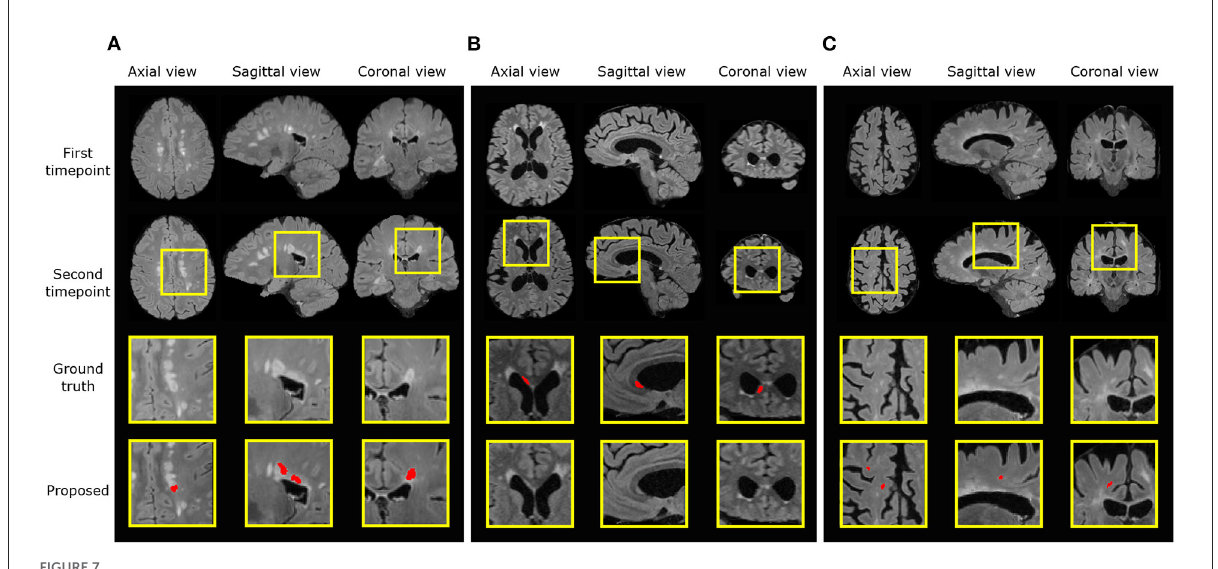
FIGURE7 Examples of three different sources of error. Ground truth and predicted lesions are delineated in red. (A) (subject ID: 012) False positive segmentation of a growing lesion. (B) (subject ID: 078) False negative classification of a new lesion. (C) (subject ID: 036) False positive segmentation of a region classified as healthy/not-new in the consensus label, but annotated as a new lesion in two of the four provided expert